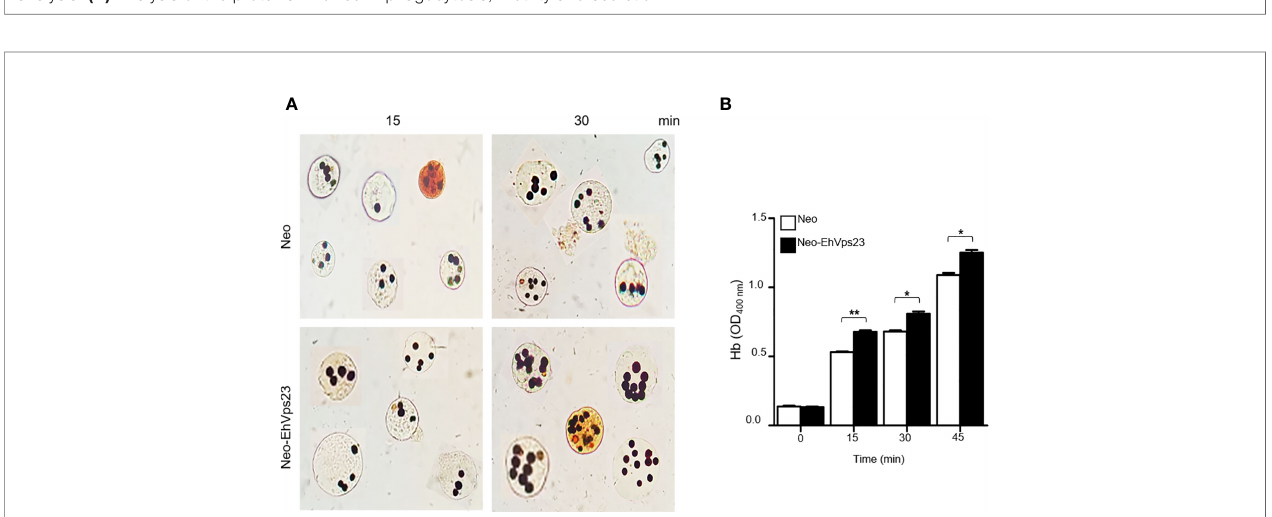
FIGURE 8 | Phagocytosis of Neo-EhVps23 and Neo trophozoites. (A) Novikoff staining of erythrocytes ingested by the trophozoites after different times of RBCs incubation at 37°C. (B) Densitometry of the hemoglobin of the erythrocytes ingested. *P < 0.05, **P <